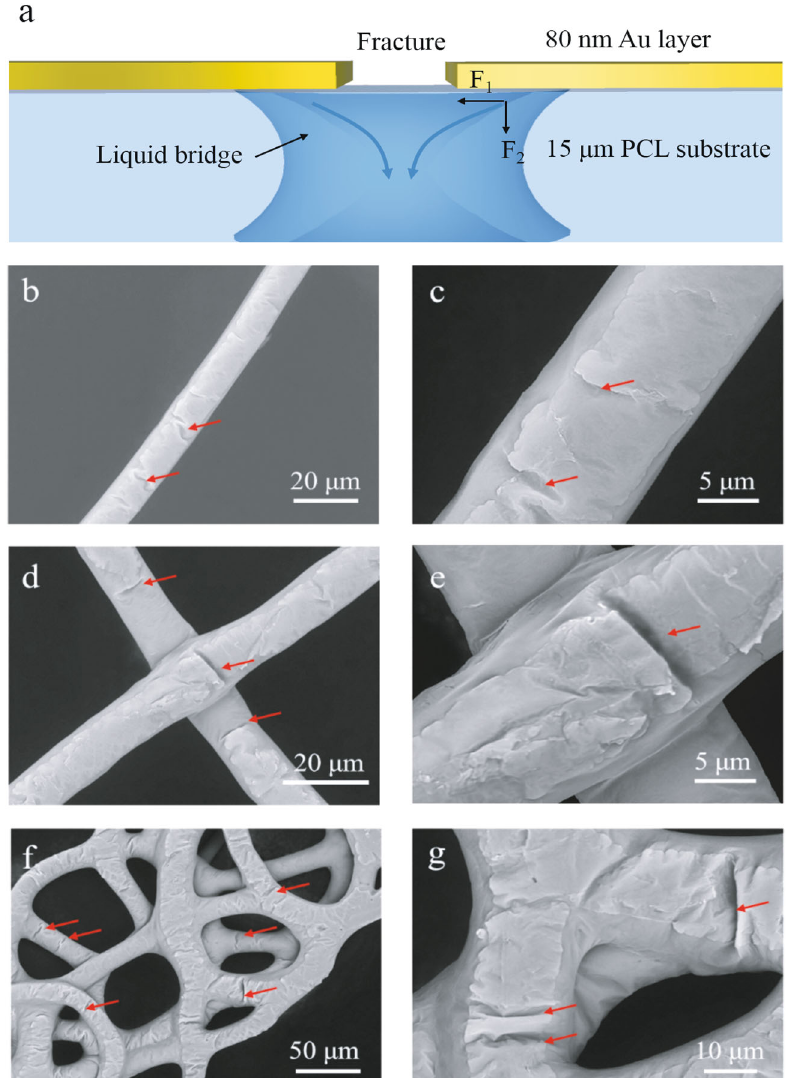
Fig. 3 Healing mechanism of van der Waals force combined with capillary force. a Schematic of adhesion force on the interface between Au and PCL layer connecting with a liquid bridge. F 1 represent the van der Waals force while F 2 represents the capillary force on the Au layer. b – g The Au-coated PCL fi ber after 40 °C b , c and after 60 °C steam treatments d – g . The shrinking positions are pointed out by red